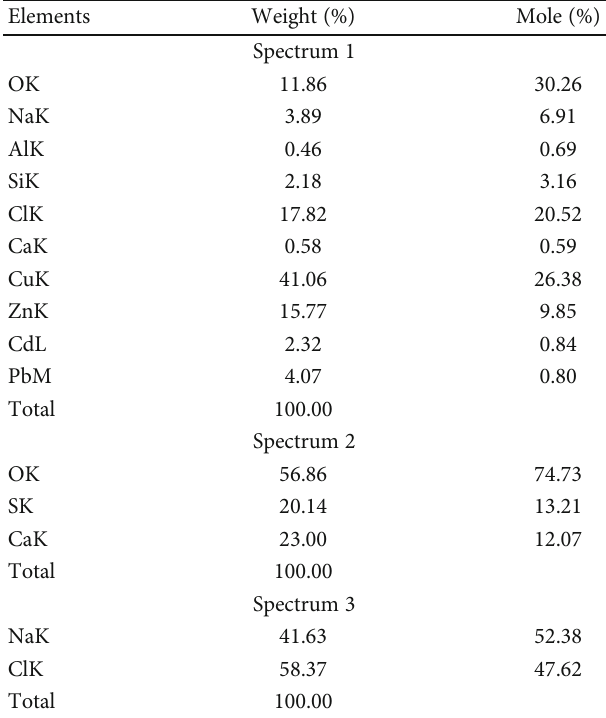
Table 1: The concentration of elements on grains in SEM of Figure 3(a).